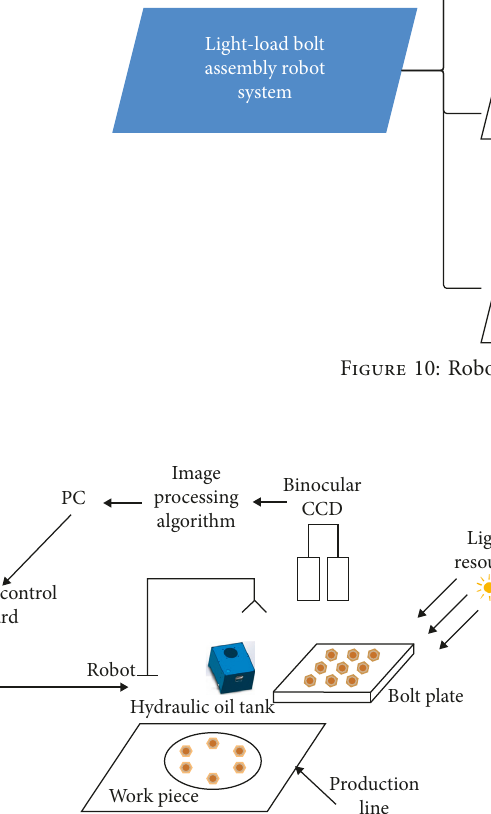
Figure 11: Schematic diagram of the workflow of the